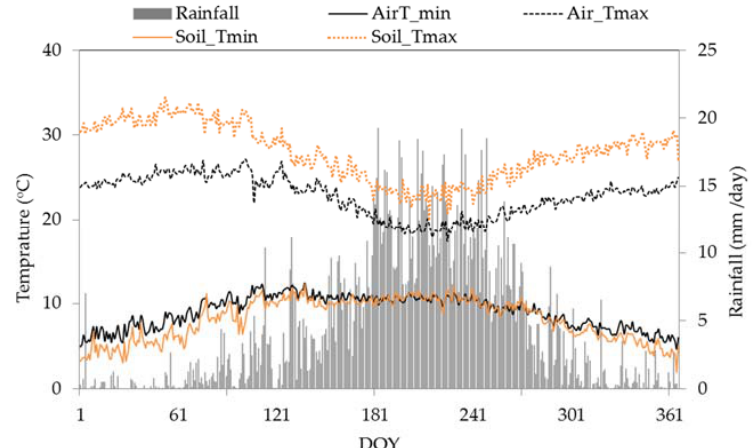
Figure 3. Daily air and soil temperature (Tmin: minimum and Tmax: maximum temperature) and daily rainfall for the Anjeni watershed (based on observations from 1989 to 1995).